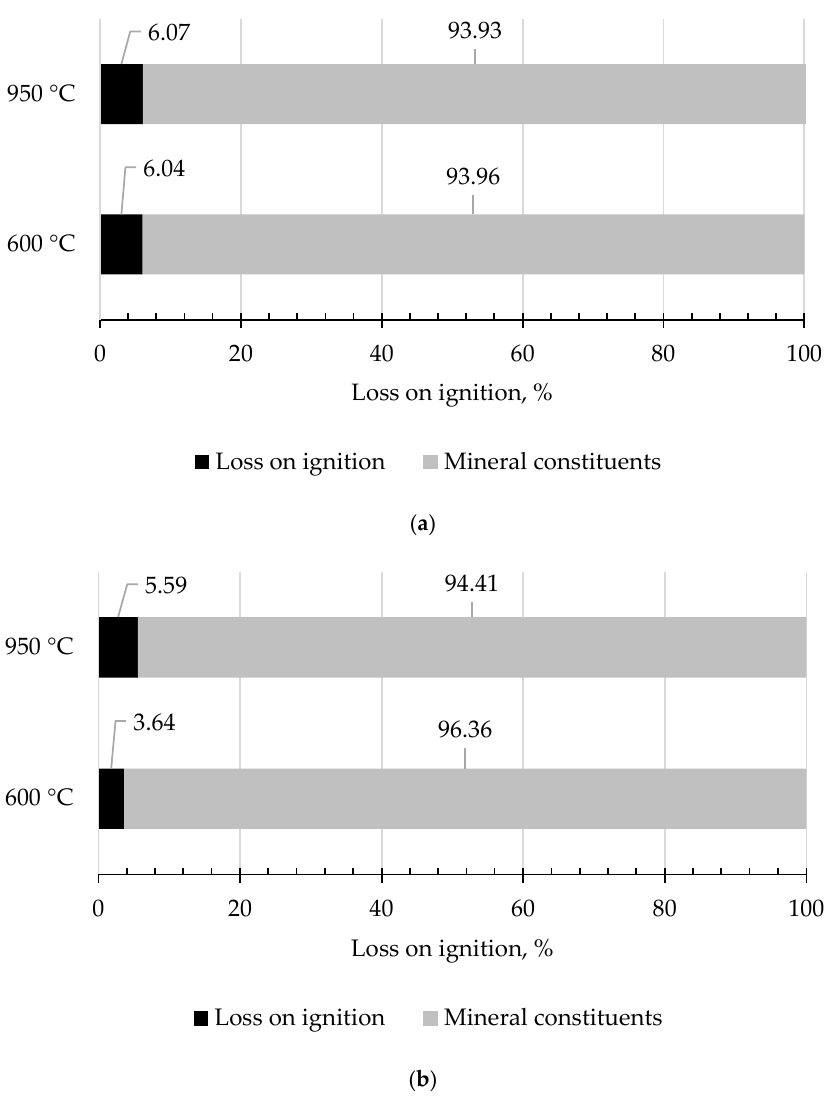
Figure 4. Loss on ignition (LOI), ( a ) slag MSWI 1, ( b ) slag MSWI 2.